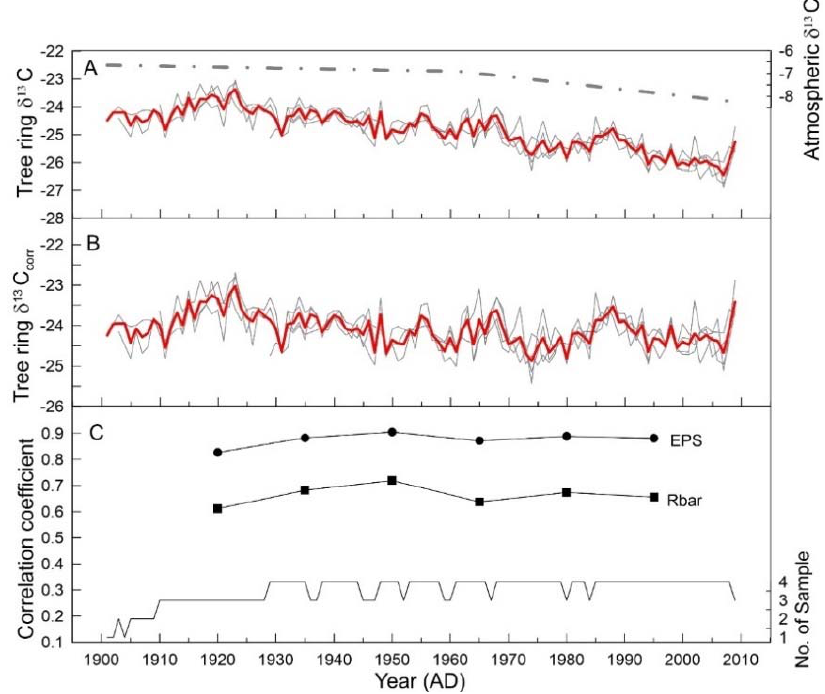
Figure 3. ( A ) Average δ 13 C TR from four trees and δ 13 C in the atmosphere; ( B ) δ 13 Ccorr series after removing the long-term decreasing trend from δ 13 C in the atmosphere; ( C ) the expressed population signal (EPS) and inter-series correlation (Rbar) statistics of the δ 13 C TR chronology.